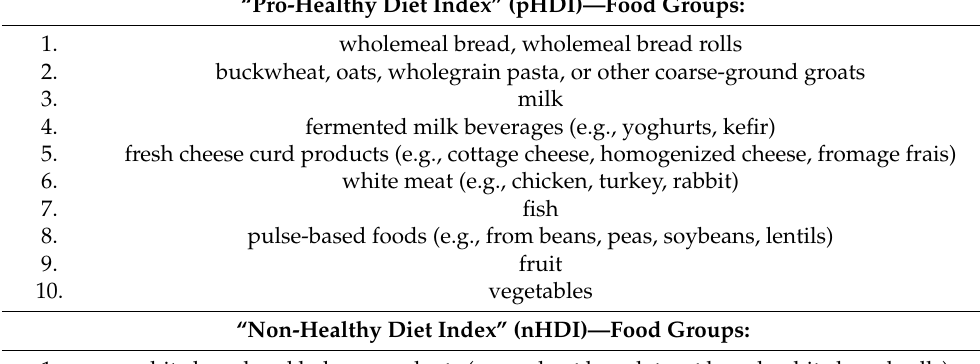
Table 1. Components of the diet indices. “Pro-Healthy Diet Index” (pHDI)—Food